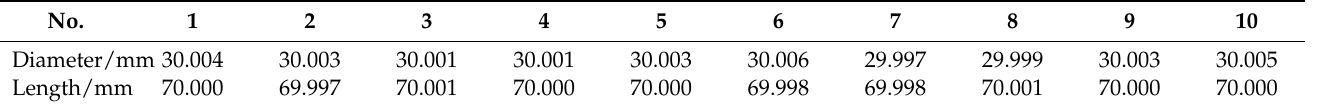
Figure 18. Images of CMM measuring standard parts. ( a ) Measuring standard sphere. ( b ) Measuring standard gauge block. Table 5. Measurement results measured with